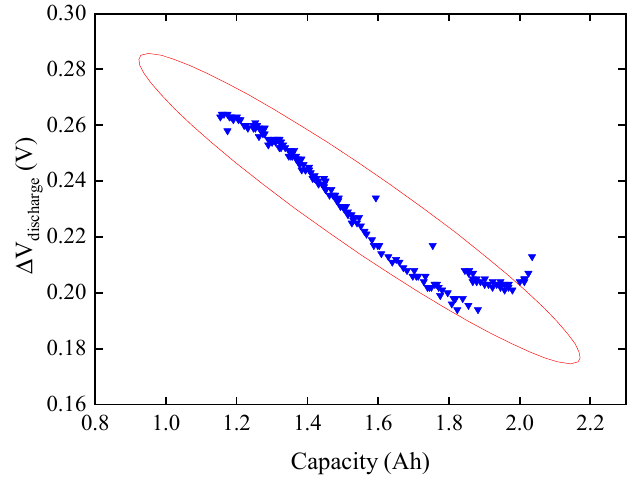
Figure 9. Scatter figure of Δ V charge .